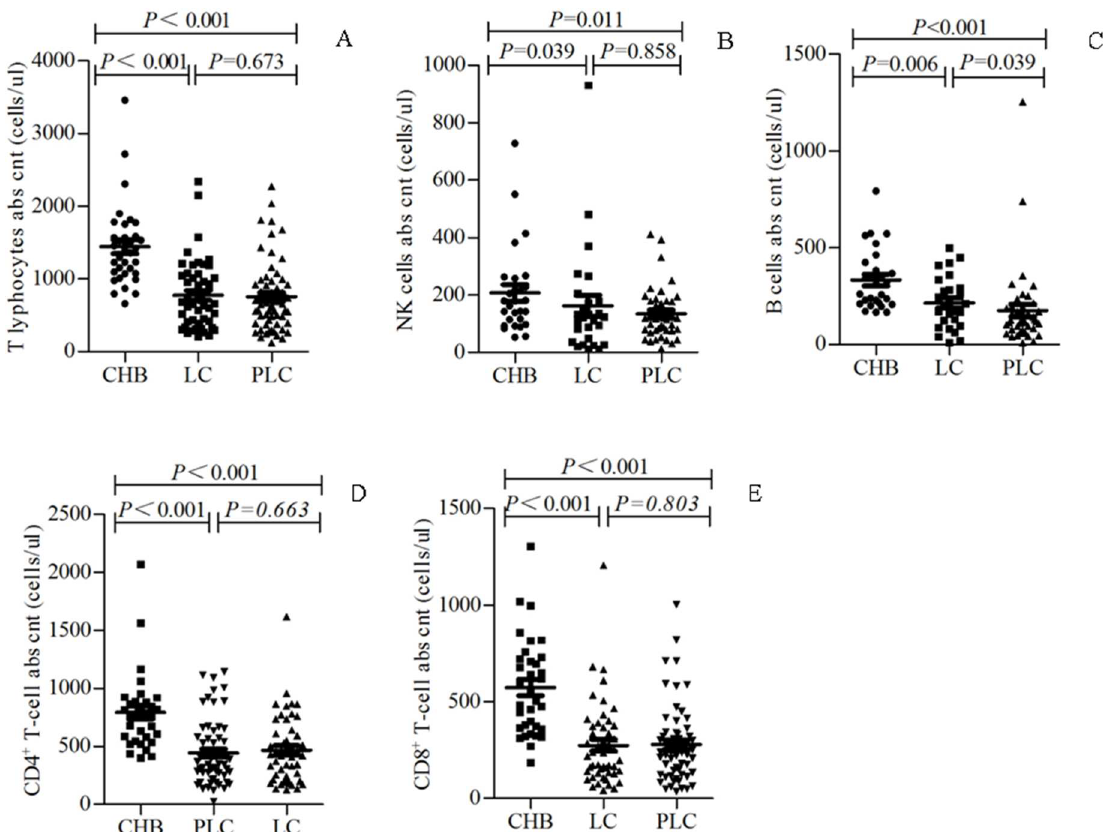
Fig 2. Decreasedperipheral lymphocyte subpopulations in patients with HBV-PLC. The concentrations of the peripheral blood T lymphocytes (A), NK cells (B), B cells (C), CD4 + T cells (D), CD8 + T cells (E) were comparedbetweenpatients with CHB, those with HBV-LC and those with HBV-PLC. p < 0.05was consideredstatistically significant.abs cnt: